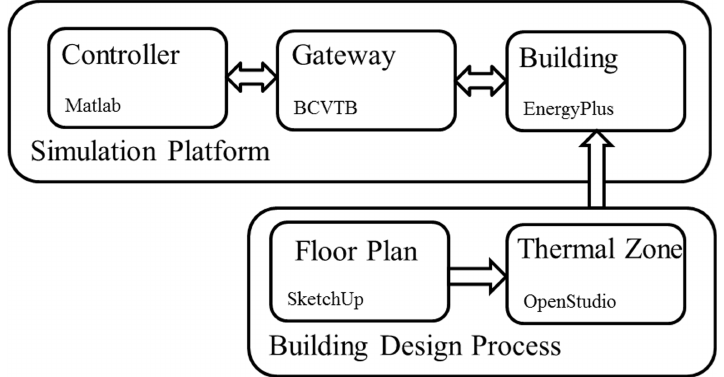
Figure 1. A conceptual flow diagram showing the entire simulation platform design process, including the building design step, as well as the control simulation platform